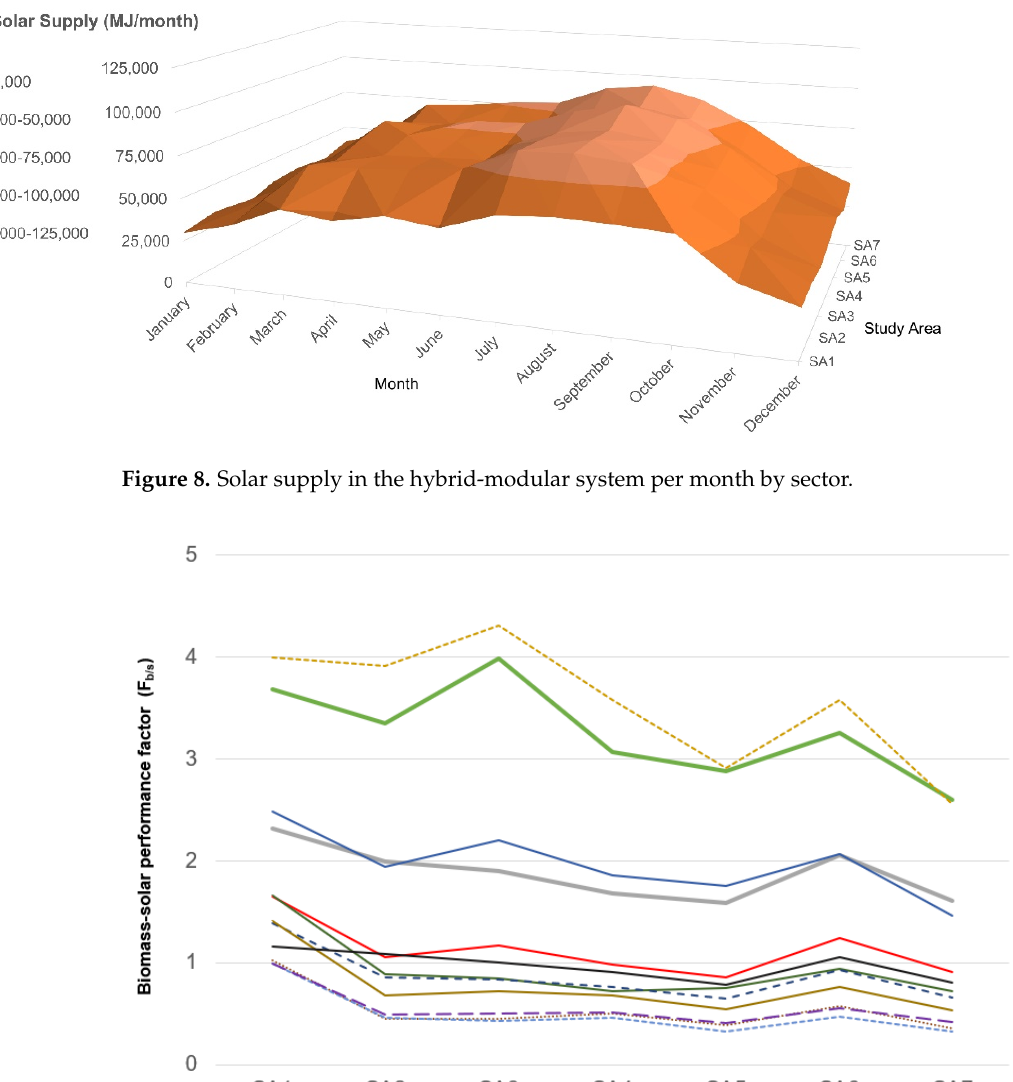
Figure 7. Bioenergy supply in the hybrid-modular system per month by sector.